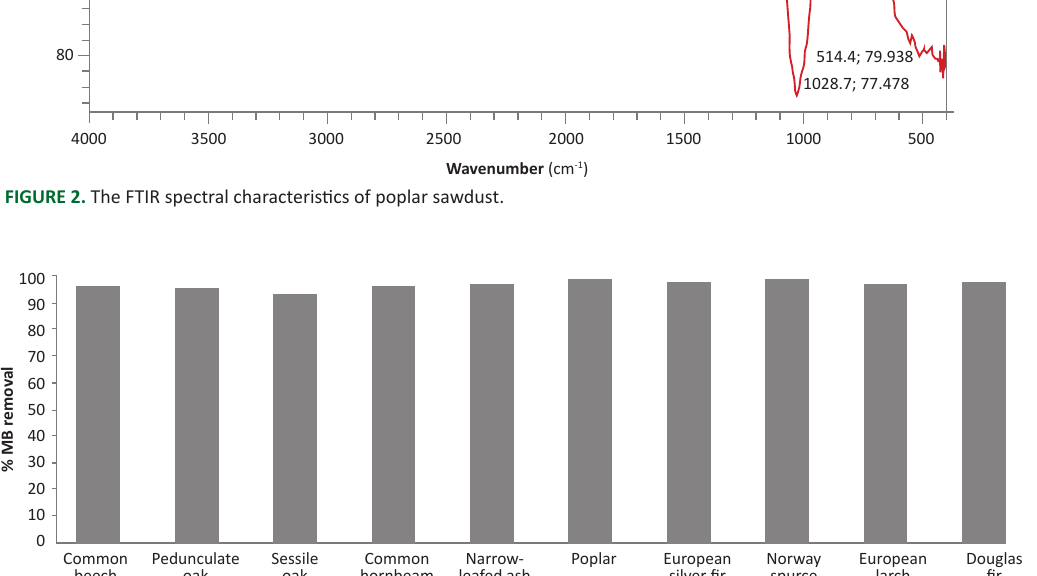
figURe 3. Adsorptive MB removal using different waste wood biomass as biosorbents (γ K, γ =10 g·dm -3 , 150 biosorbent